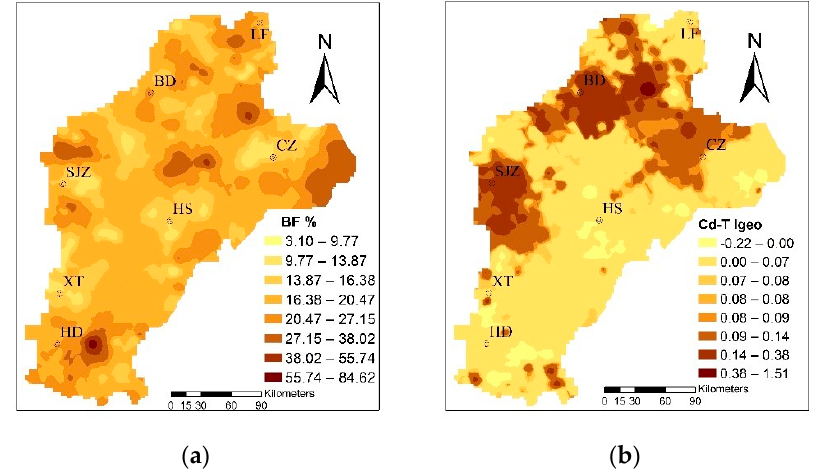
Figure 3. The distribution of the bioconcentration factor (BF%) of trace metals and the geoaccumulation index (I geo ) of total Cd in soil (Cd-T).